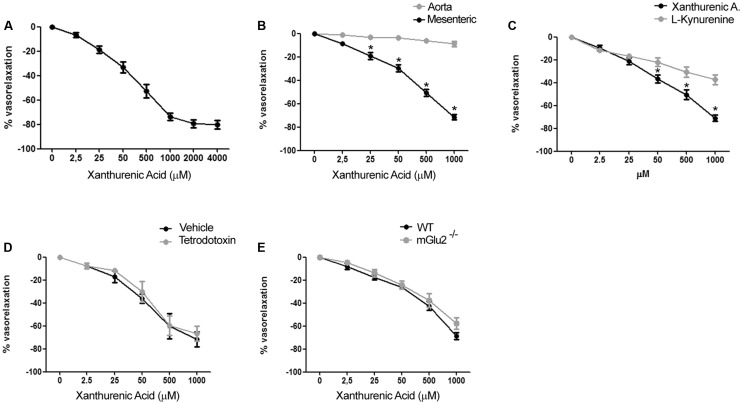
Xanthurenic acid (XA) causes relaxation of isolated mouse mesenteric arteries. (A) Concentration-response curve of XA-induced relaxation of phenylephrine-precontracted mesenteric artery. Values are means + S.E.M. of 6 determinations. (B) Vascular response of phenylephrine-precontracted mouse aorta rings or mesenteric arteries to increasing concentrations of XA (0–1000 μM). Values are means ± S.E.M. of eight determinations. ∗p < 0.05, (Two-way ANOVA + Bonferroni post-test). (C) Comparison of vascular response of phenylephrine-precontracted mouse mesenteric arteries to increasing concentrations of XA (0–1000 μM) or L-kynurenine (0–1000 μM). Values are means ± S.E.M. of six determinations. ∗p < 0.05, (Two-way ANOVA + Bonferroni post-test). (D) Vascular response of phenylephrine-precontracted mouse mesenteric arteries to increasing doses of XA in presence of (1 μM) tetrodotoxin. Values are means ± S.E.M. of 7 determination. (E) Vasorelaxing effect of XA in mesenteric arteries isolated from wild-type (WT) or mGlu2-/- mice. Values are means ± S.E.M. of five determinations.